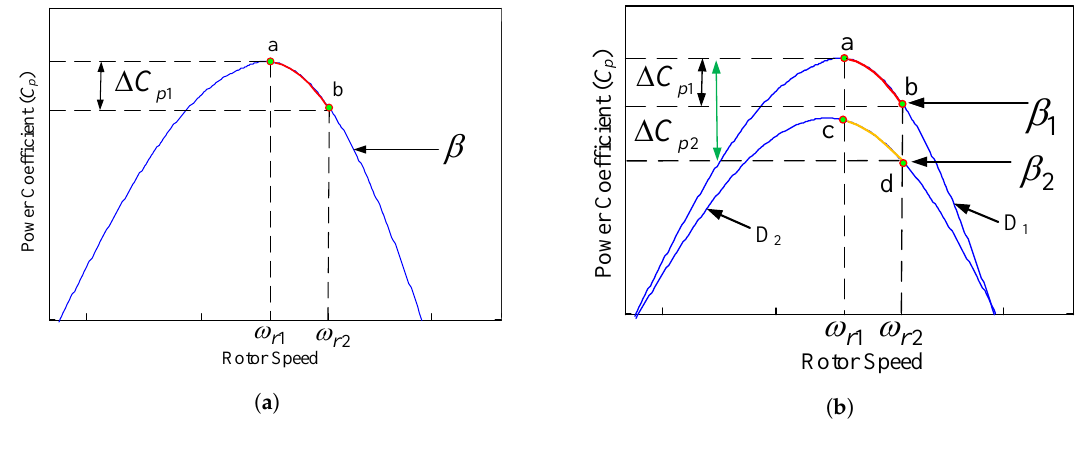
Figure 2. A typical C p curve of